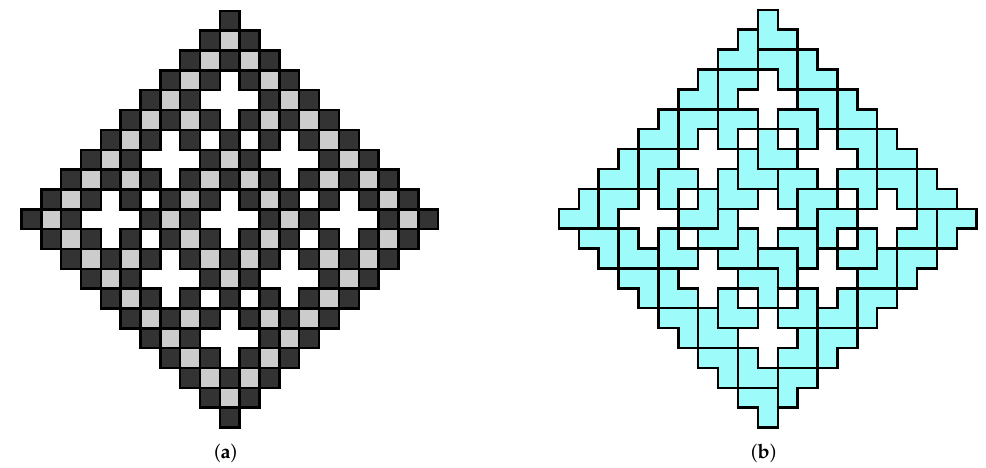
Figure 16. Target region and a tiling solution for Example 4: ( a ) the target region (cid:98) R , a checkerboard coloured irregularly shaped region with ‘holes’; ( b ) successful tiling of the target region (cid:98) R using 56 copies of an L-shaped trimino. The P + variants are coloured light-blue corresponding to an 1 optimal solution of the single pariomino tiling